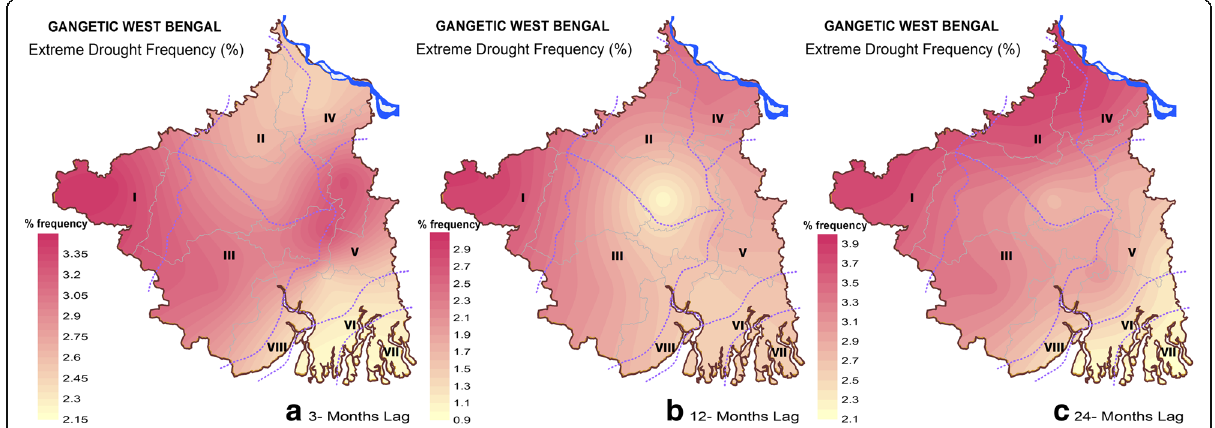
(Fig. 16a). At 12-month time step, areas of highest rain- fall requirement moved to the south and concentrated in three pockets (Fig. 16b). At 24-month time step, critical deltaic Bengal and southern part of the plateau fringe fans (Fig. 16c). Therefore, it is likely that the interior region immediately after the coastal and lower Ganga the non-irrigated croplands.